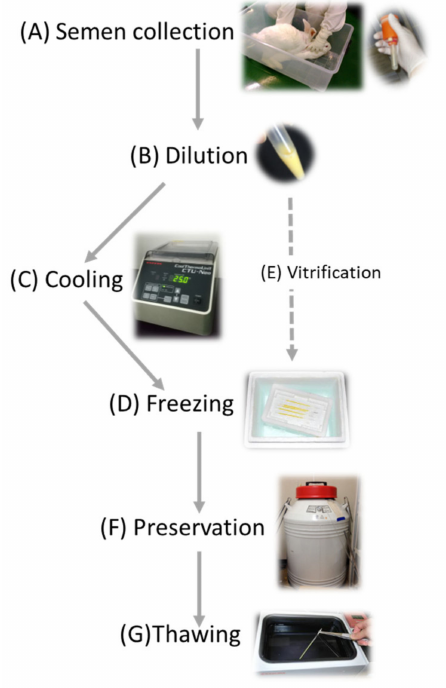
Figure 1. Schematic illustration of the essential process of sperm cryopreservation. ( A ) Semen is collected with an artificial vagina; ( B ) semen is diluted with a freezing extender; ( C ) sperm solution is cooled at slow rate (with a programming incubator); ( D ) sperm solution packed in freezing straws are frozen in vapor of liquid nitrogen; ( E ) vitrification is another option for sperm freezing; ( F ) sperms are cryopreserved in liquid nitrogen, and ( G ) sperms are thawed by immersion in a warm bath.